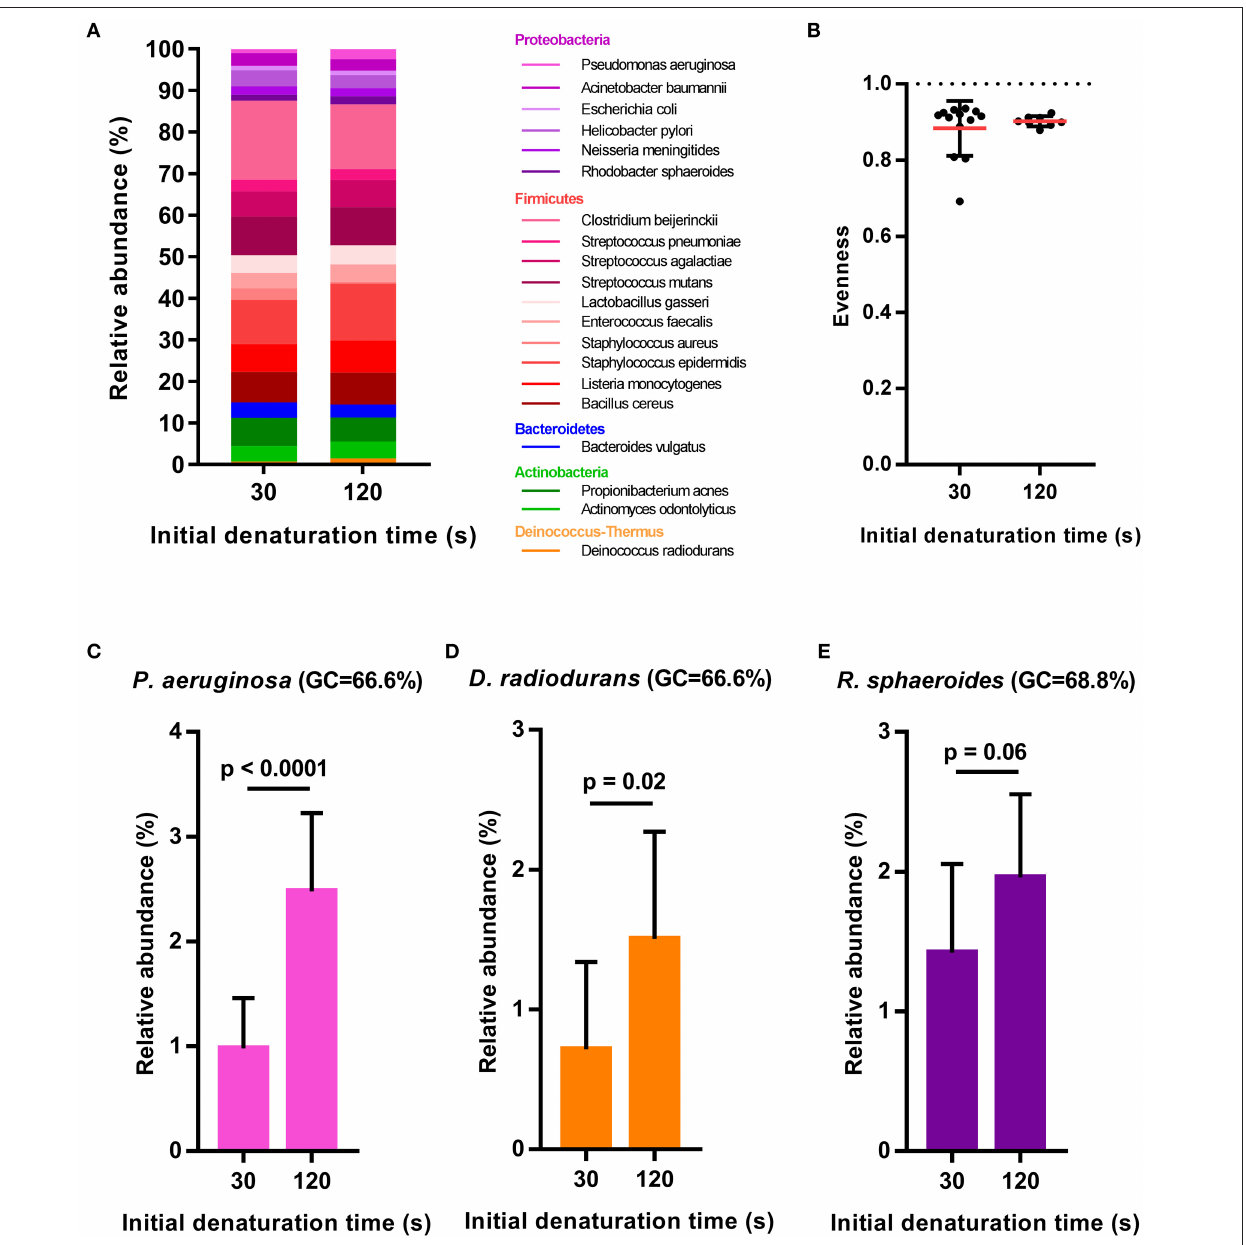
FIGURE 4 | Relative abundance estimates of the 20-member mock community following different initial denaturing times of 30s ( n = 13) or 120s ( n = 8) during the library preparation PCR. (A) Bar plots of mean relative abundances of all mock community members, (B) Evenness of the mock community with dashed line indicating the expected evenness of 1 and (C–E) Bar plots showing mean relative abundance + sd for the three mock community members with highest GC-content. Statistical significance is evaluated by t